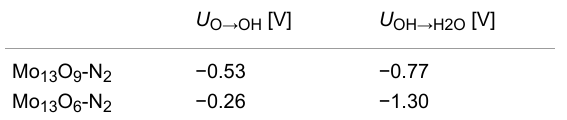
Table 5: The required potentials for reducing oxygen at two oxygen coverages, when nitrogen molecules are present on the partly covered oxygen